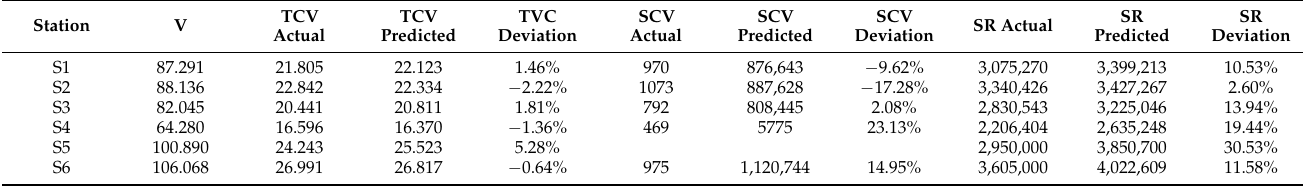
Table 9. Validation calculations for material quantity prediction models.